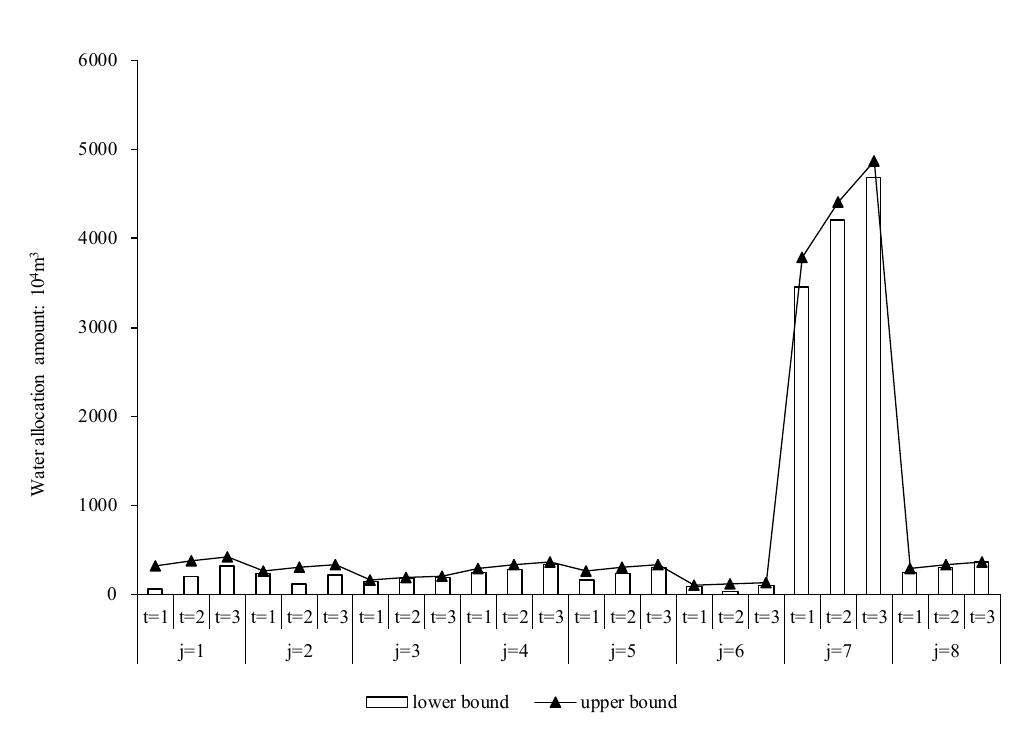
Figure 5. Reused water resource allocations for the environment. Table 3. Optimal water resource pre-allocations for the Yinma River Basin (10 4 m 3 /year). Regions Departments